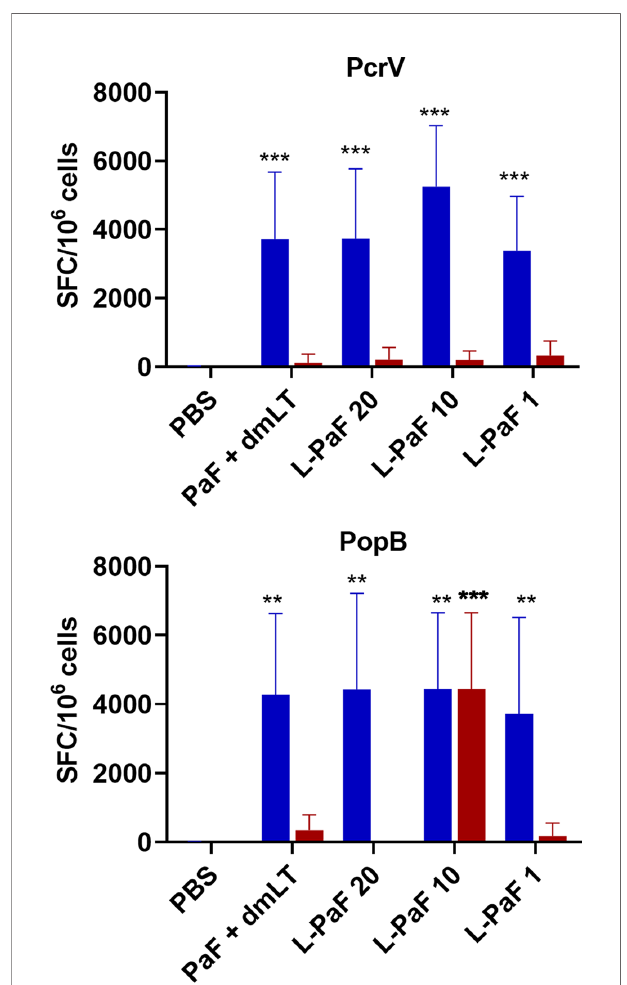
FIGURE 7 | Frequency of IL-17 and IFN- g secreting cells from pre-challenge mice after antigen-speci fi c stimulation. Mice (n=10) vaccinated with PBS, PaF (20 µg) admixed with dmLT (2.5 µg) or with 20, 10 or 1 µg of LTA1-GSAAS- PaF (L-PaF) on days 0, 14, 28. The single lung cell suspensions were obtained and used to assess antigen speci fi c IL-17 and IFN- g secreting cells. Cells were incubated with 10 µg PcrV (top) or PopB (bottom). IL-17 (blue bars) and IFN- g (red bars) secreting cells were enumerated by ELISpot and are presented here as spot forming cells/10 6 cells. The data are plotted as means ± SD for individual mice in each group. Signi fi cance was calculated by comparing groups that were unvaccinated (PBS) and mice vaccinated with antigens using two-way ANOVA. **p < 0.01; ***p <